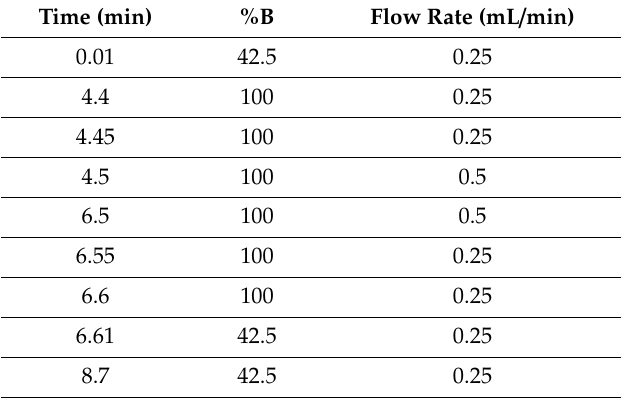
Table 2. Injection Profile. Table 2 provides the liquid chromatography injection profile for separation of the steroids. %B = percentage of mobile phase B at the corresponding